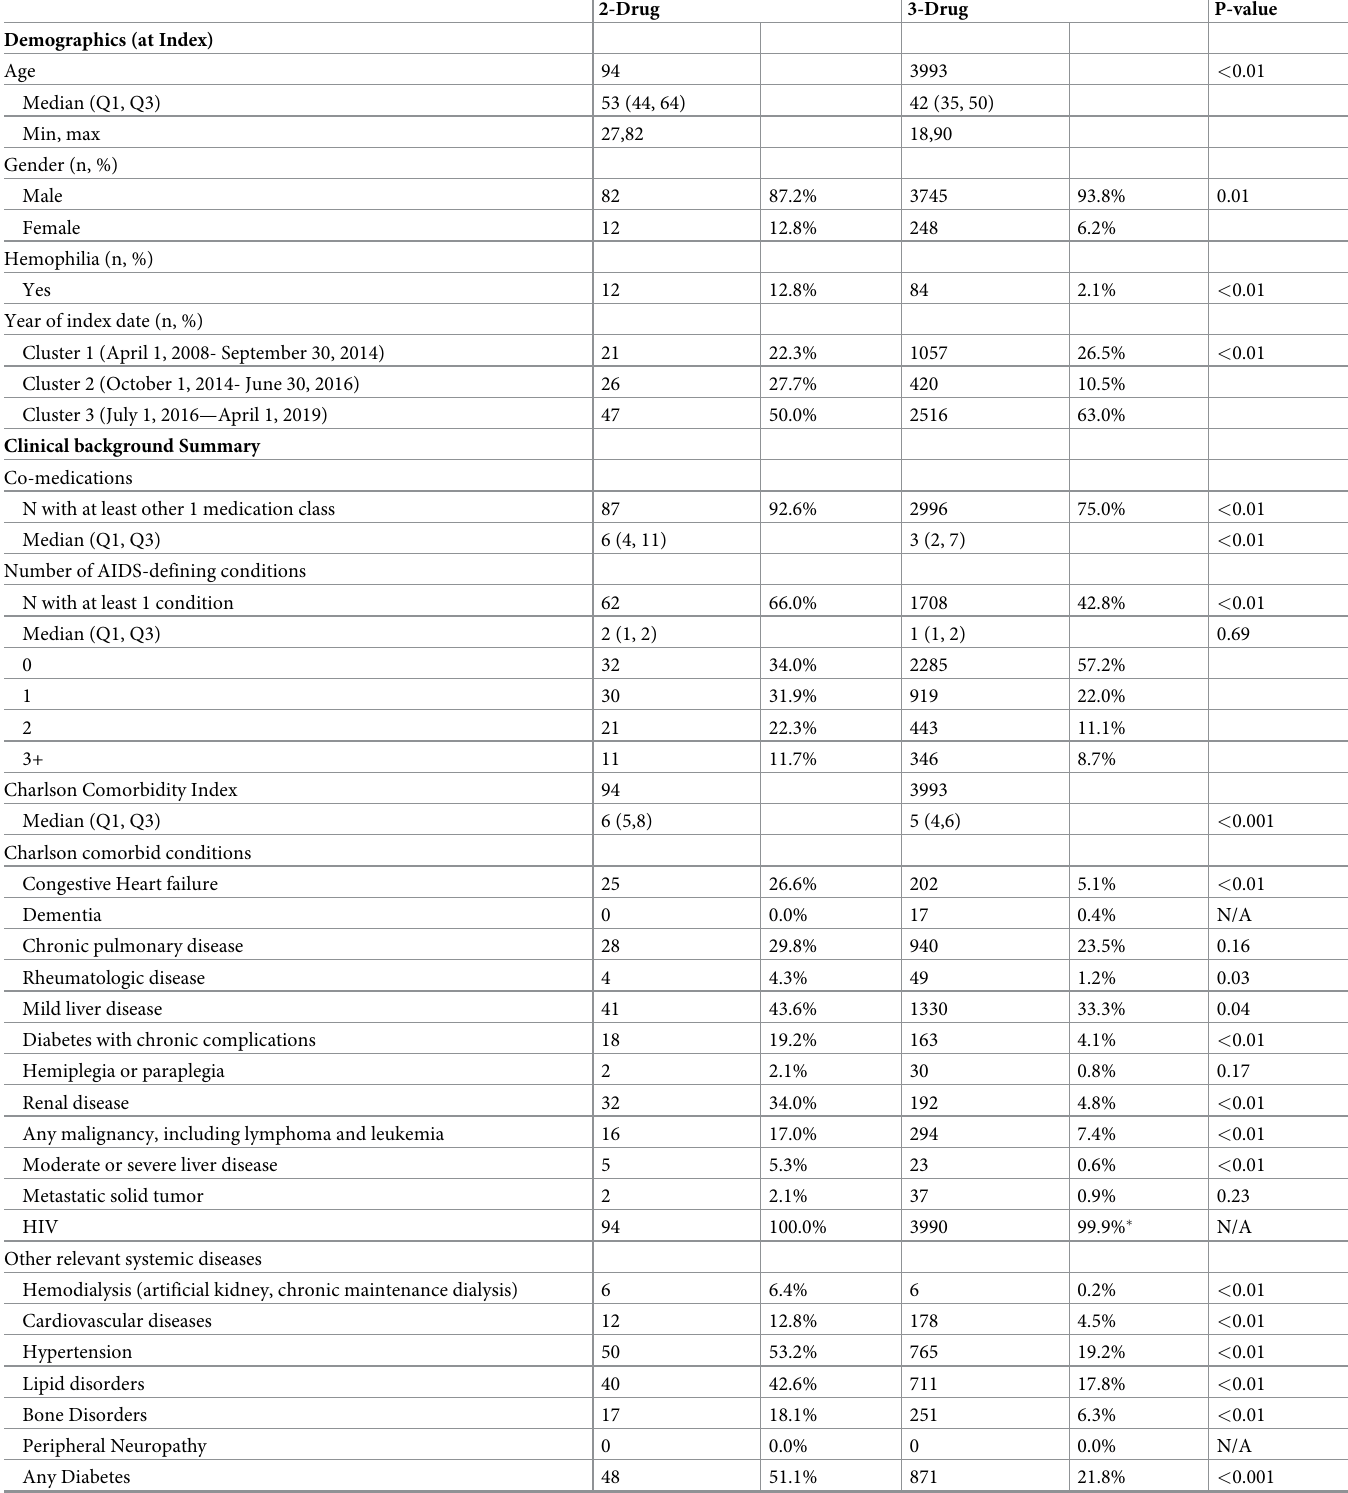
Table 1. Baseline